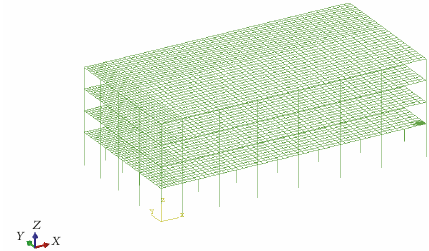
Figure 2: Numerical example of a 4-story steel frame. vectors relative to the ground, respectively; {1} is the vector with all elements equal to unit; and ̈𝑥 𝑔 (𝑡) is the ground acceleration.